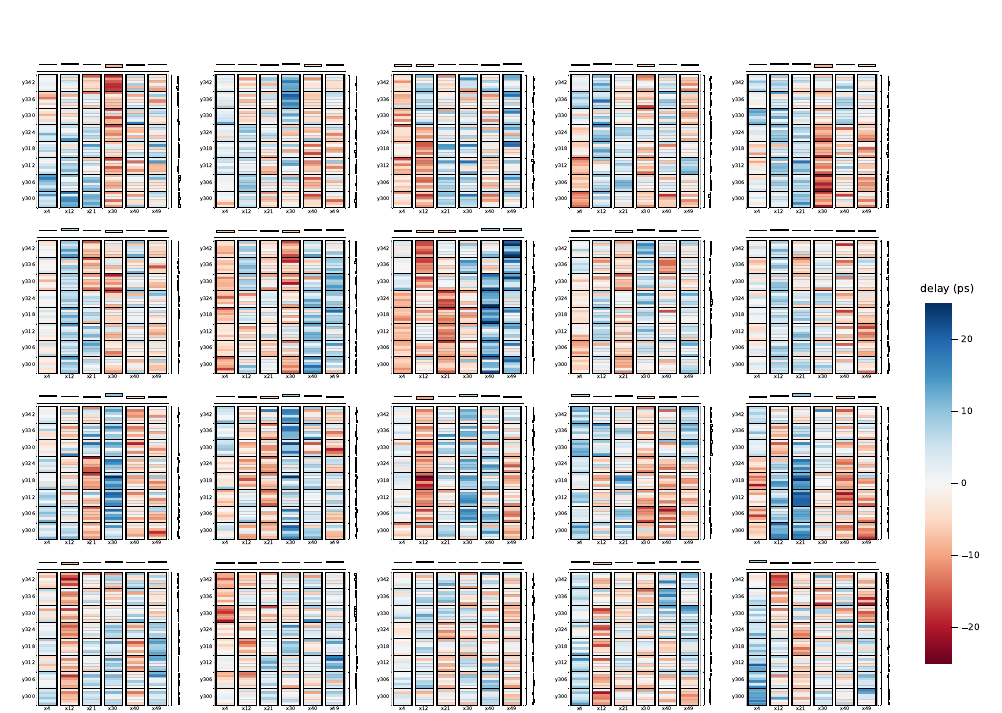
Figure 6: Across 20 chip instances, the difference between measured delays on a chip and the delay from the regression model; in other words, the residual of the model. The histogram in Fig. 5b summarizes the same